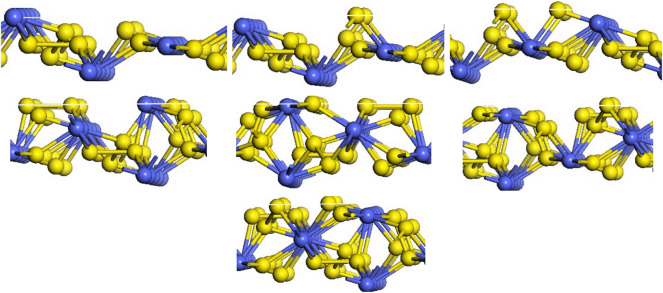
Different terminations of the CoS2 (211) surface.